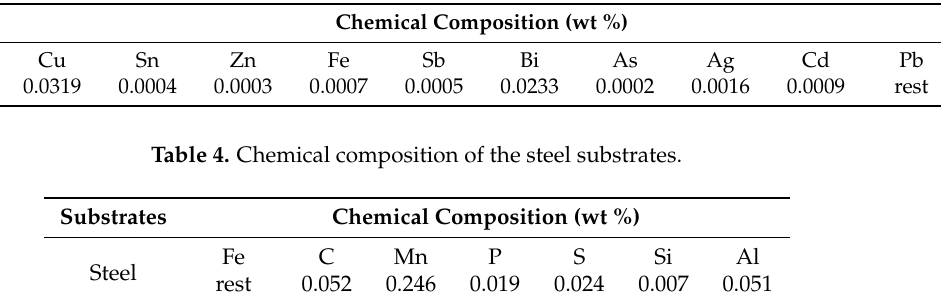
Table 3. Chemical composition of the lead substrates.